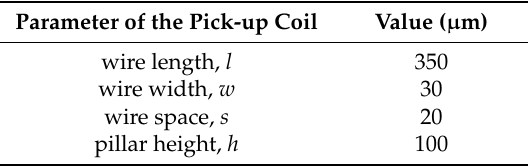
Figure 4. The effect of coil parameters on the inductance-factor. ( a ) The effect of wire length on the inductance-factor; ( b ) The effect of wire width on the inductance-factor; ( c ) The effect of wire space on the inductance-factor; ( d ) The effect of pillar height on the inductance-factor. Table 2. The parameters values of the pick-up coil.